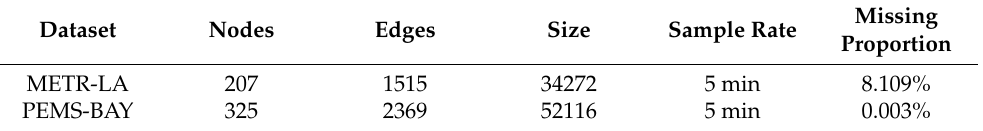
Table 2. The statistics of of